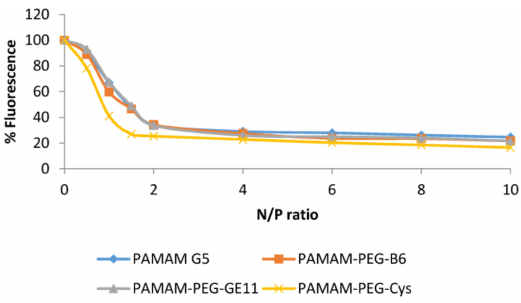
Figure 1. Condensation assay: siRNA condensation measured as a decrease in fluorescence of EtBr added to